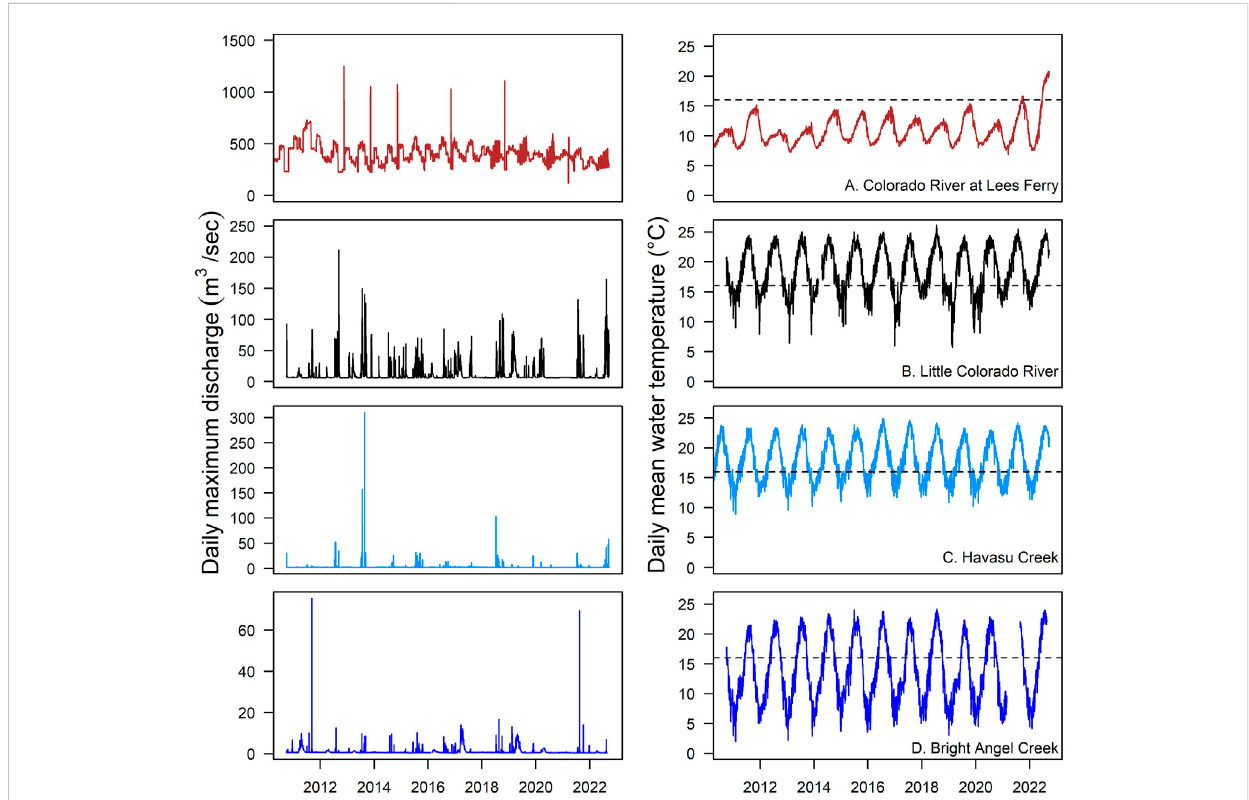
FIGURE 5 Dailymaximumdischarge(m 3 /s)anddailymeanwatertemperature( ° C)fromU.S.GeologicalSurvey(USGS)gagingstationsontheColoradoRiverat Lees Ferry row (A) , and major Grand Canyon tributaries including the Little Colorado River (B) , Havasu Creek (C) , and Bright Angel Creek (D; gauge Number 09403000). Horizontal dashed lines on temperature plots indicate a minimum threshold for successful reproduction for humpback chub ( Gila cypha ) for reference. Data sources: Colorado River, USGS gaging station 09380000 (US Geological Survey, 2022a); Little Colorado River, USGS gaging station 09402300 (US Geological Survey, 2022b); Havasu Creek, USGS gaging station 09404115 (US Geological Survey, 2022c); Bright Angel Creek, USGS gaging station number 09403000 (US Geological Survey,